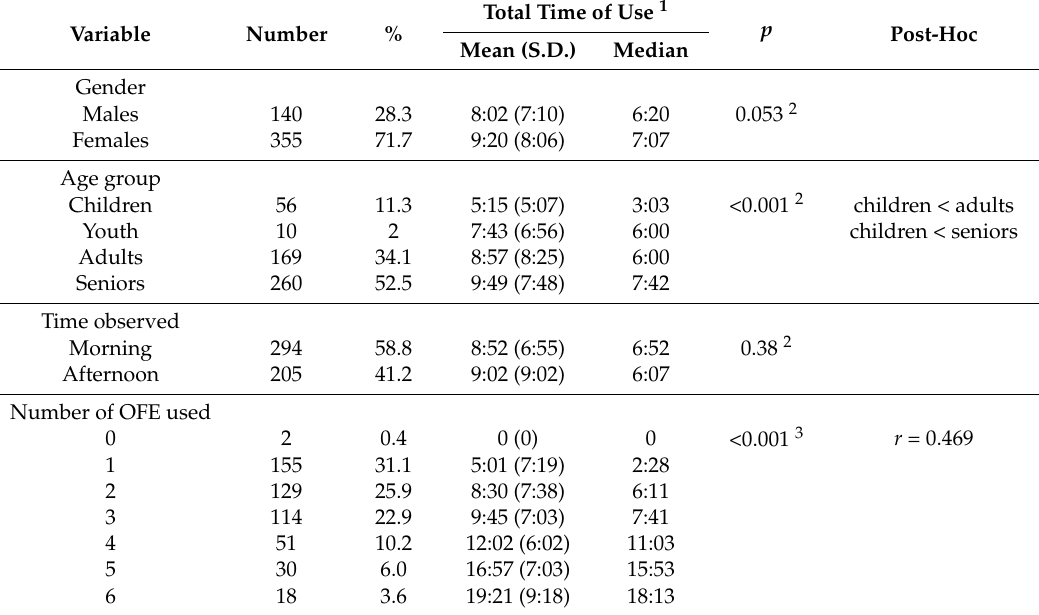
Table 2. OFE users’ characteristics and patterns of use and comparison of total time